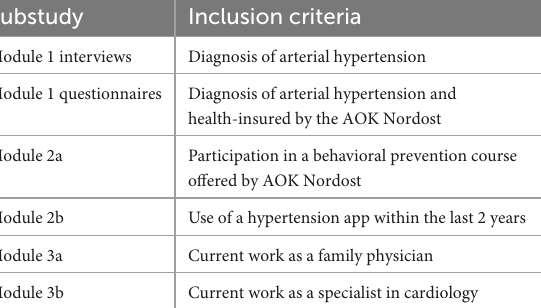
TABLE 2 Additional inclusion